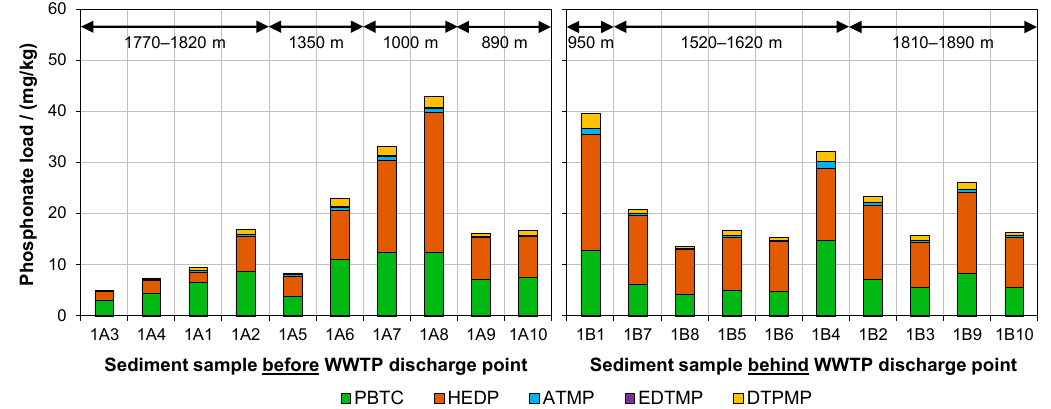
Figure 5. Phosphonate loads of sediment samples from the first sampling (CW31) taken at different locations in River1 and analyzed individually (meters indicate the distance to the WWD, key “1A1”/”1B1”: 1: first sampling, A/B: before/behind the WWD, 1: sampling